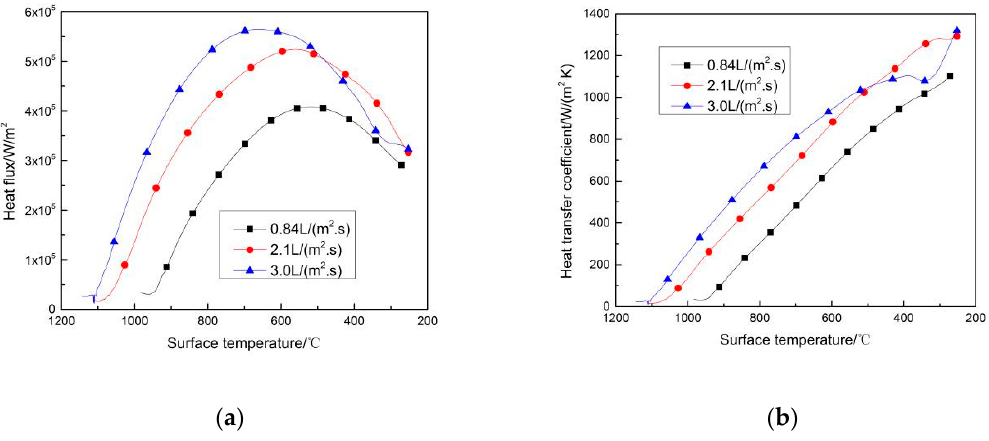
Figure 11. Heat characteristics with different water flux for ( a ) heat flux; ( b ) HTC.